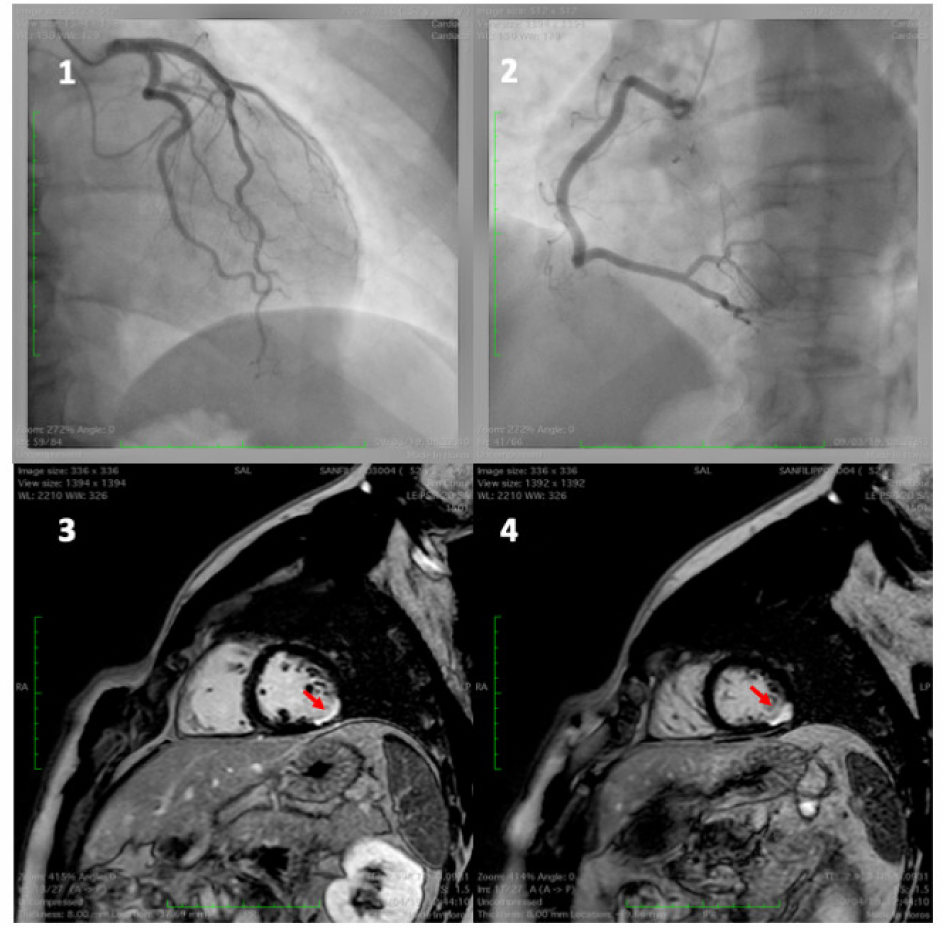
Figure 2. A 49-year-old man admitted for inferior ST elevation myocardial infarction. Coronary angiography showed no coronary lesions on left and right coronary artery ( frames 1 and 2 ). The MRI, one day later, detected ischemic lesions (delayed enhancement) of sub-endocardial ( frame 3 ) and transmural ( frame 4 ) inferior–lateral